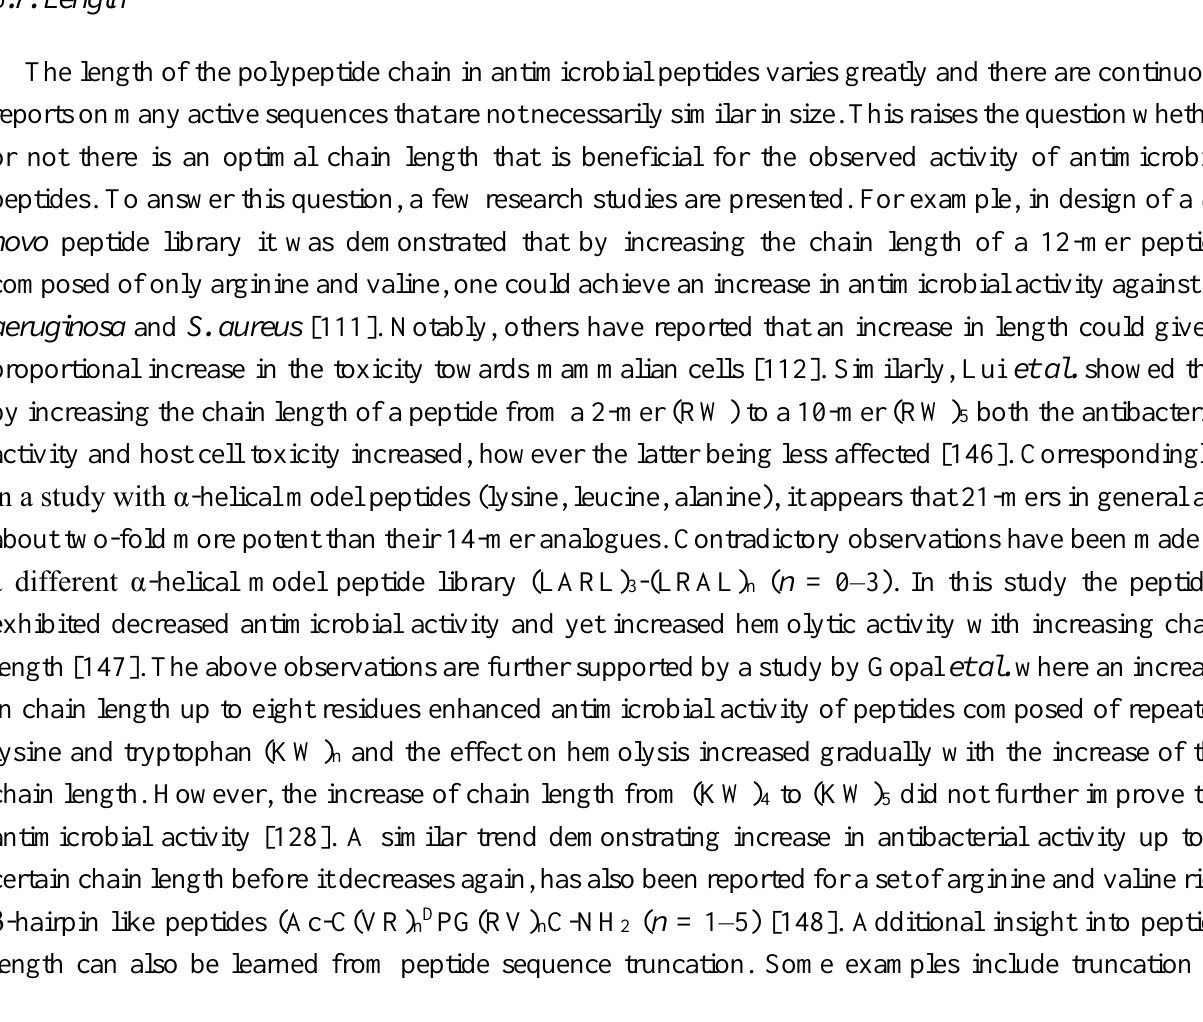
Figure 6. Cyclic peptides and lipopeptides. Covalent structures of some conventional and lead drug molecules. ( A ) Gramicidin S; ( B ) Tyrocidines; ( C ) Polymyxin B; ( D ) Daptomycin and ( E ) cyclo-[ D -Ala-(12-guanidinododecanoyl)Thr- D -Val-Val-DaThr- D -Asn] [145]. 6.7.